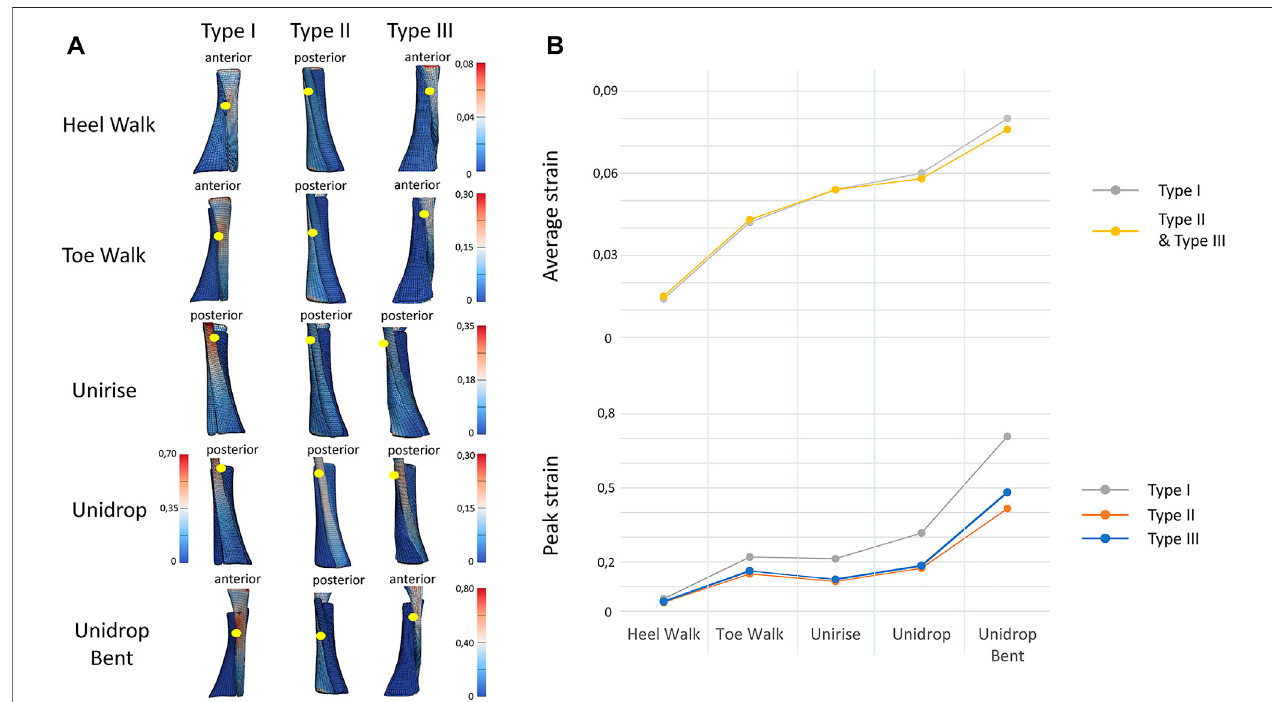
FIGURE 2 | (A) . View of the distribution of the maximum Lagrange strain for the three types of twist and for all the fi ve rehabilitation exercises. The yellow dots indicate the location of the peak strain. (B) Trend of the peak and average of the maximum Lagrange strain for all the types of twist and all the rehabilitation exercises, in the mid-portion of the tendon models. In average strain, Type I and Type II strain are described with the same line, since the values are the same.